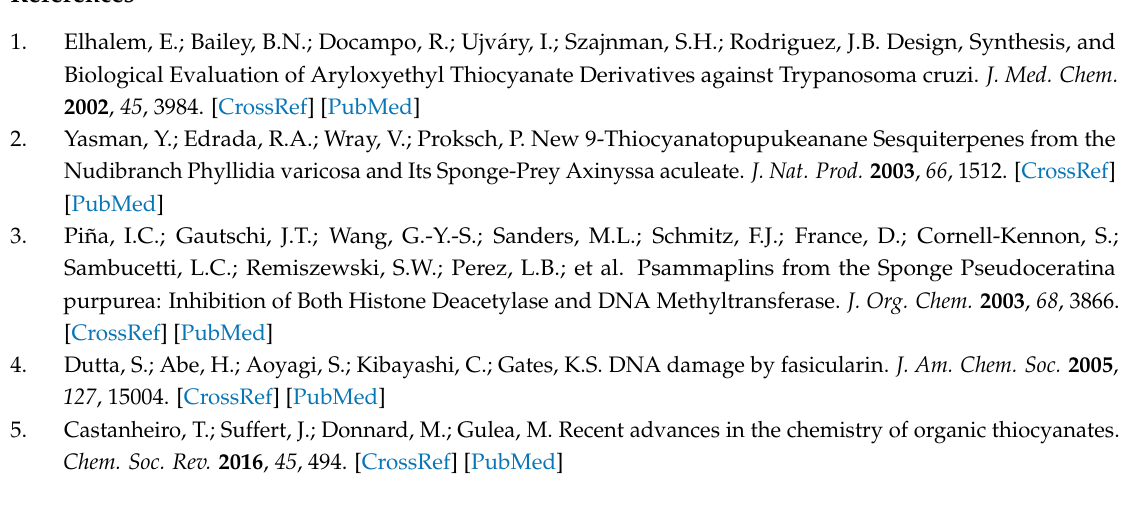
Supplementary Materials: The following are available online, general methods, X-ray crystallography details for oxindole 2g , mechanistic studies, and 1 H-NMR and 13 C-NMR spectra of all products. Author Contributions: D.-L.K. and W.-H.F. conceived and designed the experiments. D.-L.K., J.-X.D. and W.-M.C. performed the experiments. D.-L.K. wrote the manuscript. C.-Y.M. and J.-Y.T. revised the manuscript. All authors read and approved the final